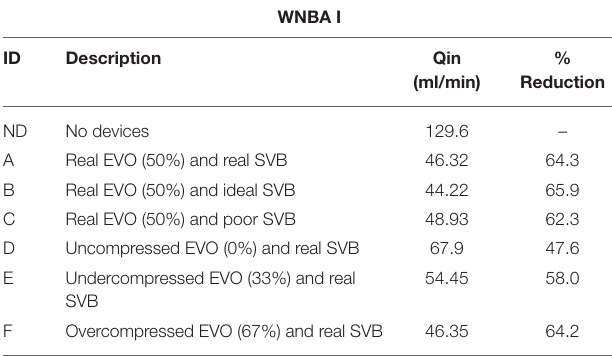
TABLE 2 | Percentage reductions of total flow entering the sac of WNBA I with different deployment strategies and different compression level.